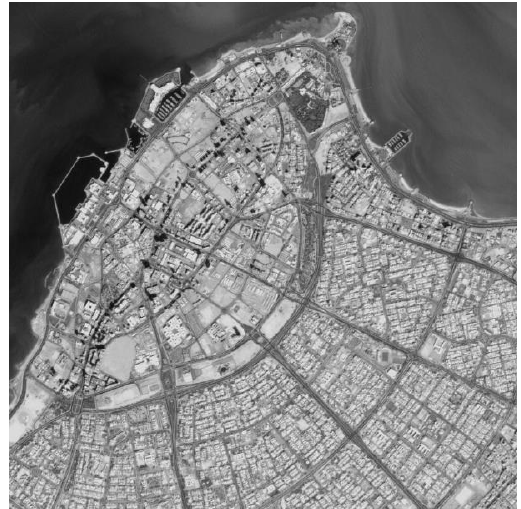
Figure 1. Original image covering Kuwait city (Resourcesat